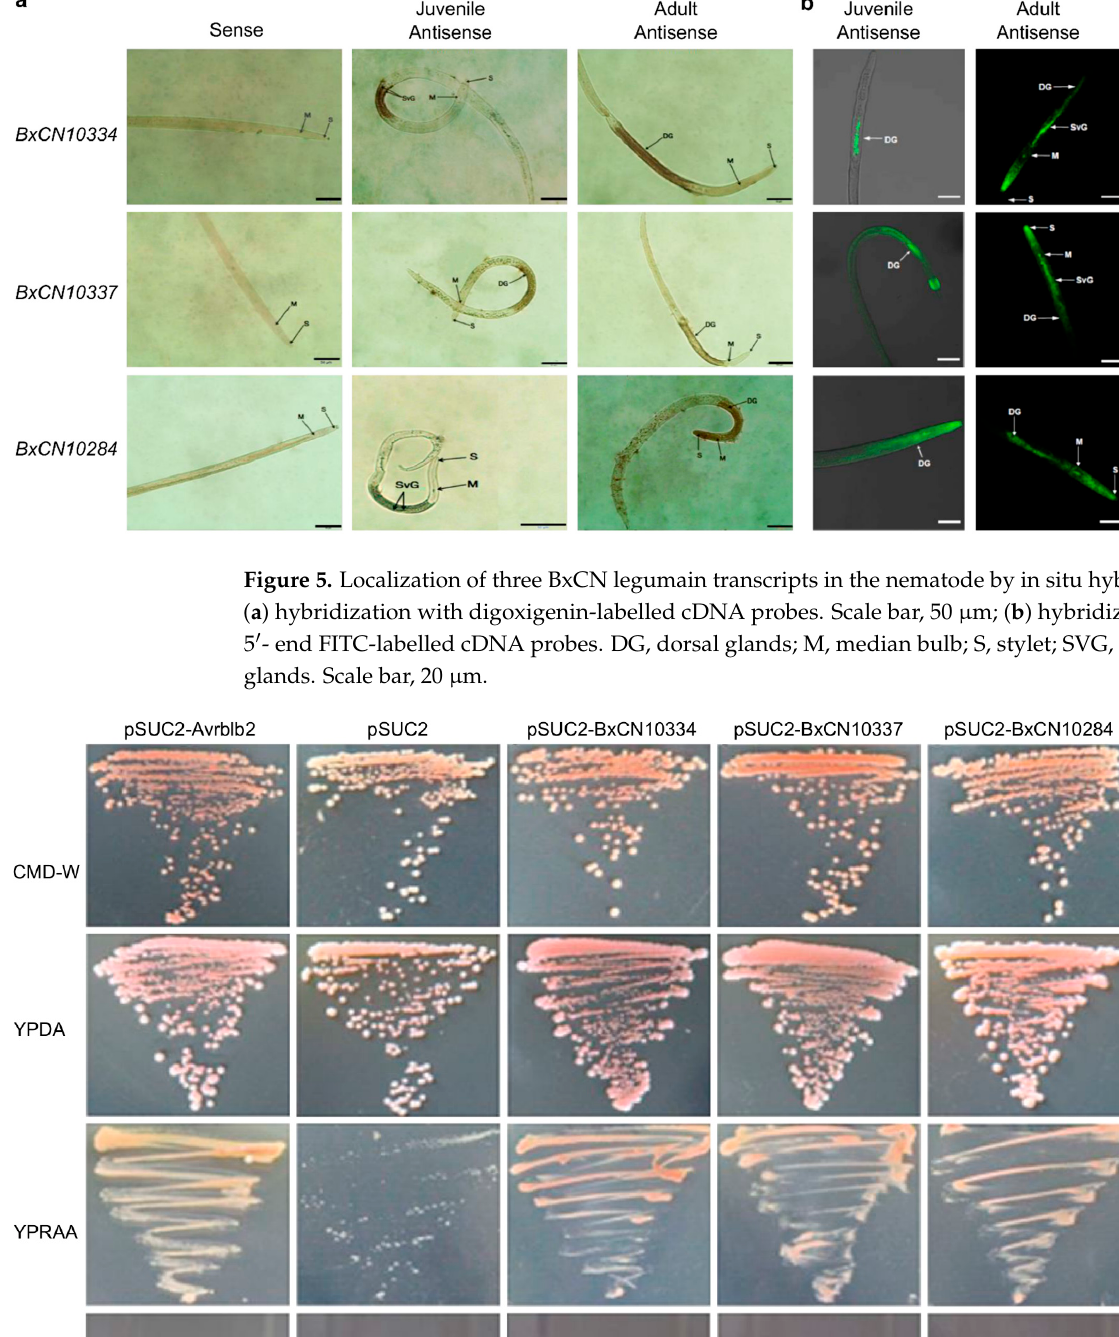
Figure 6. Yeast invertase secretion assay of the signal peptides of the above three BxCN legumains. Yeast YTK12 strain carrying signal peptides of BxCN10334, BxCN10337, and BxCN10284, are able to grow in raffinose-containing YPRAA medium, and react with TTC to display red color. YTK12 carrying the Avrblb2 and the pSUC2 vector are used as positive and negative controls, respectively. CMD-W, YPDA, and YPRAA, are culture media. TTC, 2,3,5-triphenyltetrazolium chlo- ride. 2.6. Identification of Genes Involved in Nematode Legumain-Mediated FB1-Induced Plant Cell Death To determine which genes are involved in nematode legumain-mediated FB1- induced plant cell death, we sequenced and compared transcriptomes of four types of Arabidopsis plants, i.e., ∆ γ vpe mutant, the wild type, transgenic lines introduced with BxCN10334 , and BxCN10337, each with two replicates. By comparison with gene ex- pression in the mutant transcriptomes, a total of 910, 2442, and 1958, differentially ex- pressed genes (DEGs) are identified from the transcriptomes of the wild type, the trans- genic lines introduced with BxCN10334 and BxCN10337 Arabidopsis plants, respectively ( p < 0.05 and |log2FC| ≥ 1). Among them, 59 DEGs display similar expression patterns (26 up-regulated and 33 down-regulated) in the transcriptomes of wild type and the two transgenic lines, contrast to the transcriptome of ∆γ vpe mutant (Figure 7a, Supplemen- tary Table S7). Among 26 upregulated DEGs, four encoding E3 ubiquitin ligases (BRH1, ILP, BRG1, BRG2) and two encoding F-box proteins (EBF2, AFB2) are putatively in- volved in protein ubiquitination and proteasome-mediated ubiquitin-dependent protein catabolic process; three encoding protein kinases (PID, PK1B, PPCK1) and one encoding an ethylene response factor (ERF106) are possibly involved in signal transduction; one (AT2G30230) encoding a 6,7-dimethyl-8-ribityllumazine synthase is involved in re-